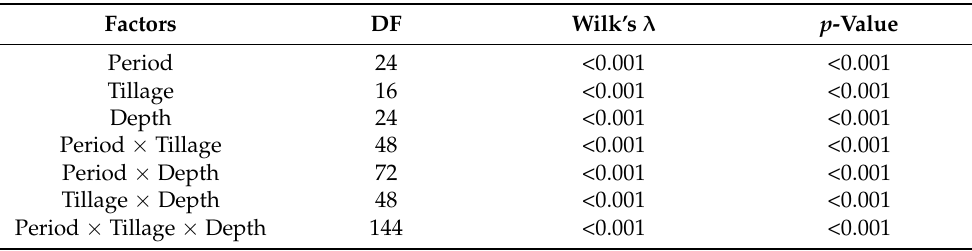
Table 4. Multivariate analysis of variance (MANOVA) results to assess the effect of period, tillage, depth and their interactions over eight measured soil properties.